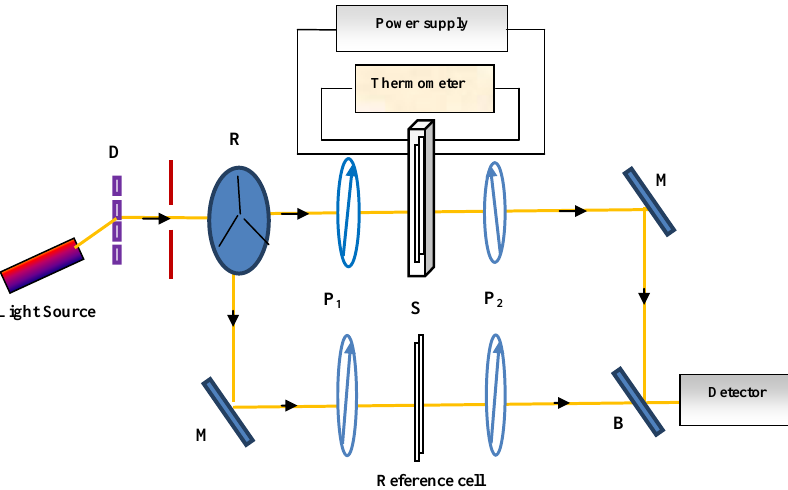
Figure 7. Optical set-up of spectrophotometry for measuring the transition temperatures of liquid crystalline materials, where D: diffraction grating; R: rotating disc (Sample, blank, shutter); M: mirror; B: beam splitter; P 1 and P 2 are polarizer and analyzer respectively; S: sample inside the electric oven.